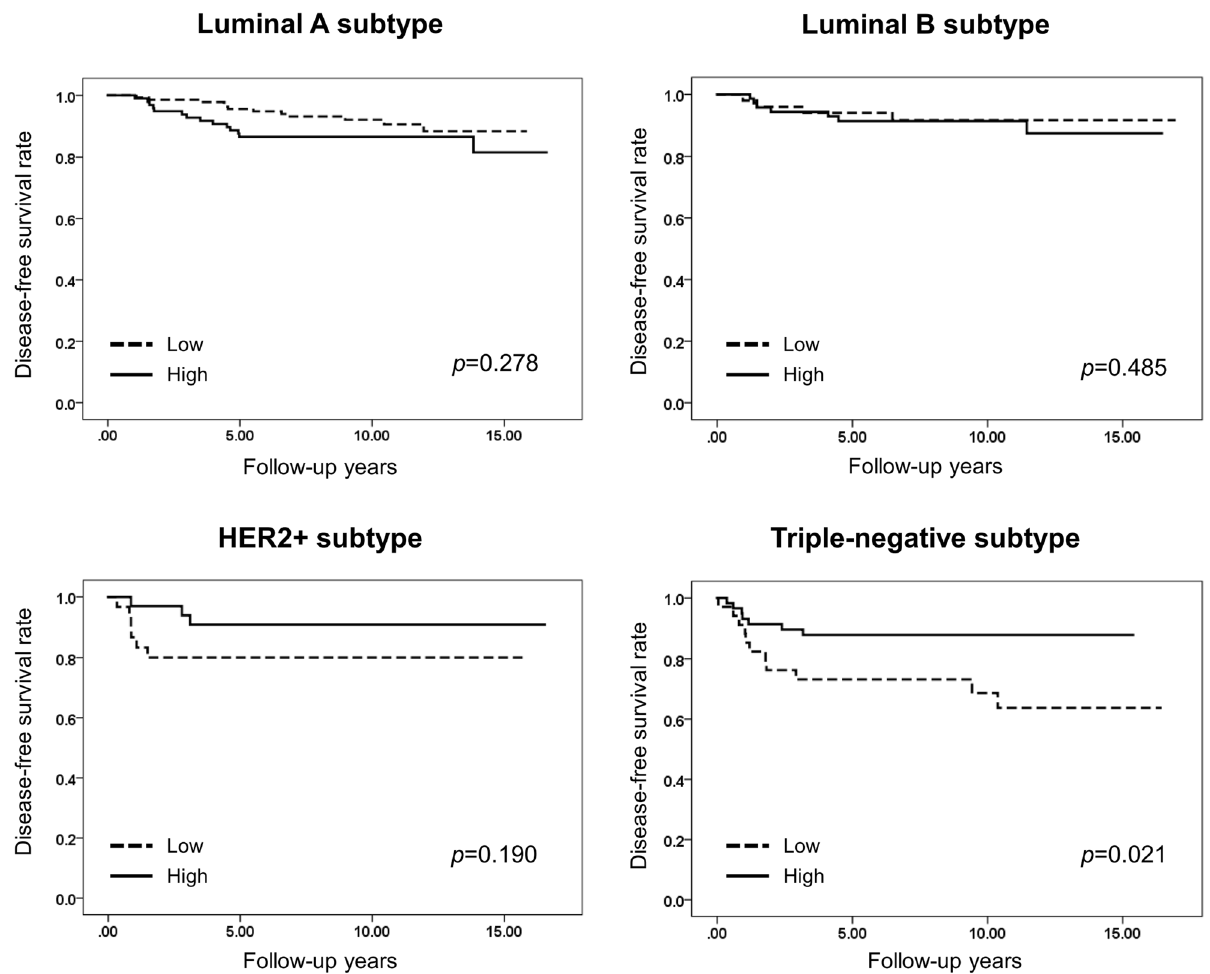
disease-free survival in triple-negative subtype, but not in luminal A, luminal B, and HER+